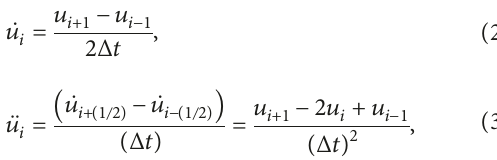
Detonation of explosives on the